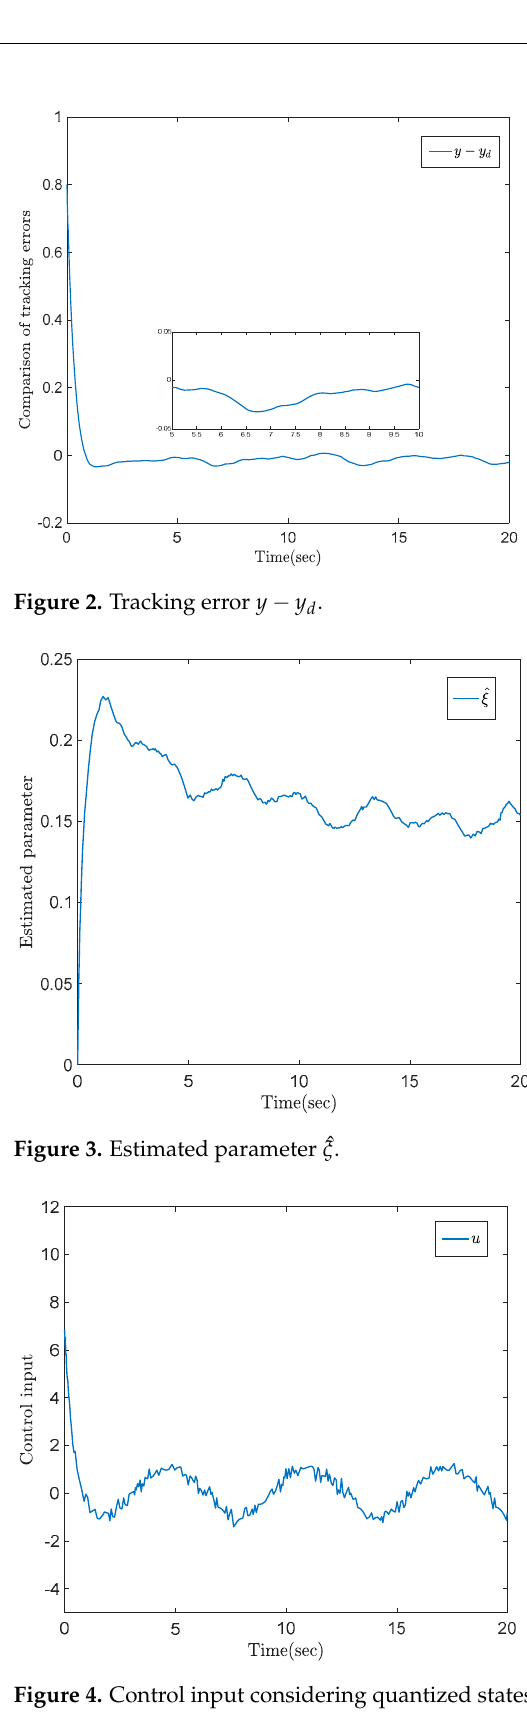
Figure 4. Control input considering quantized states.